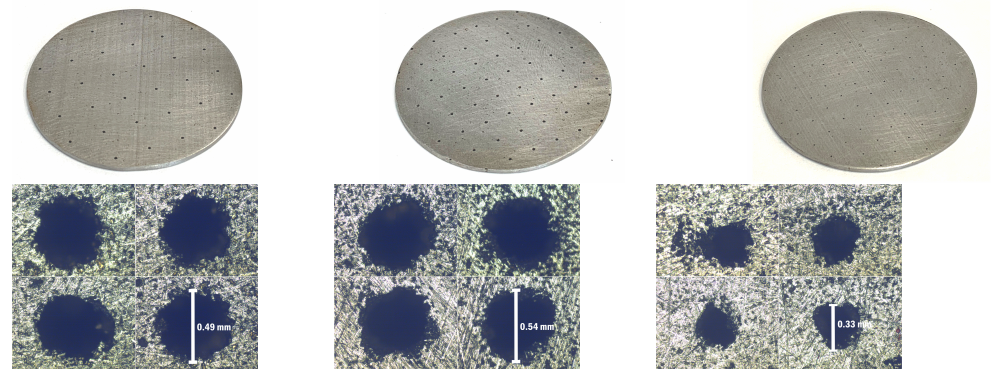
Figure 6. The three MPP samples ( top ) and the effective visualisation of perforations seen at the microscope ( bottom